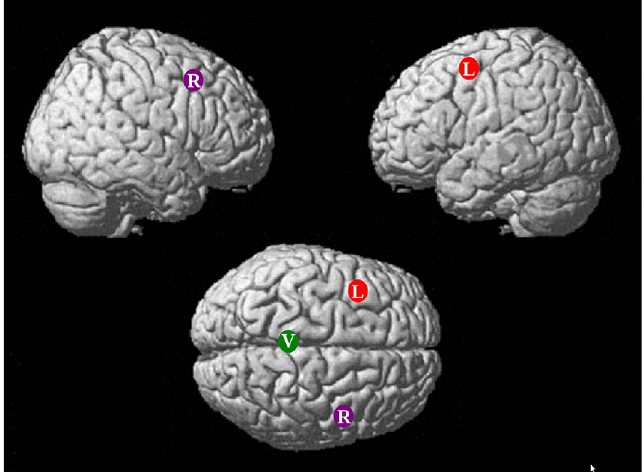
Figure 5. TMS targets for all three sessions (L, R, V) presented on a standard brain surface. Brain surface provided by the SPM12